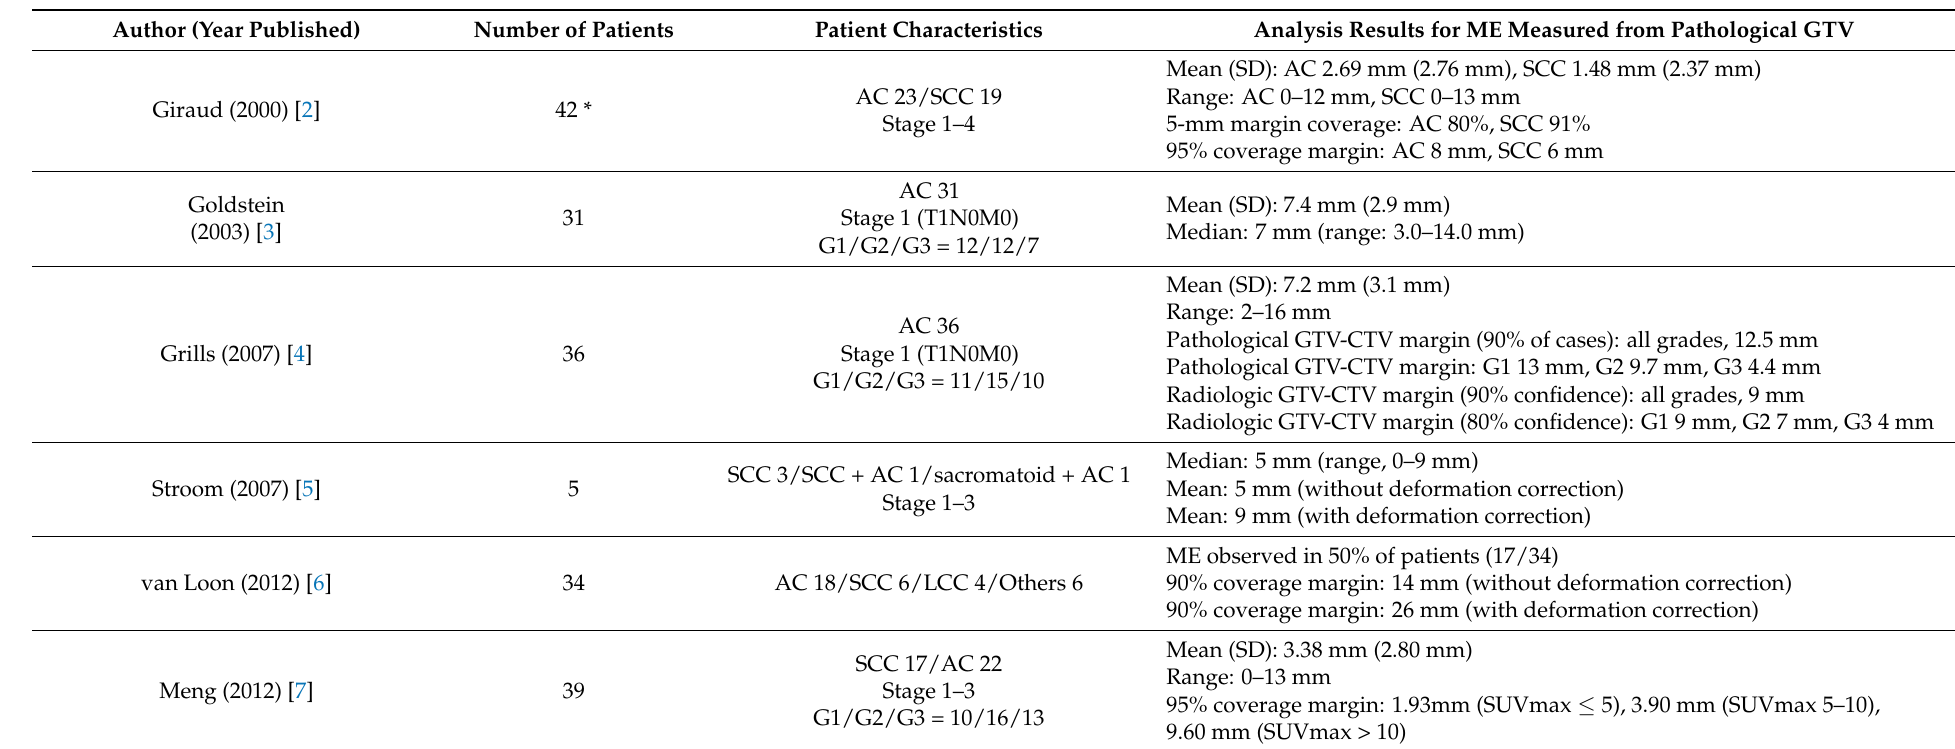
Table 1. Studies reporting ME into the lung